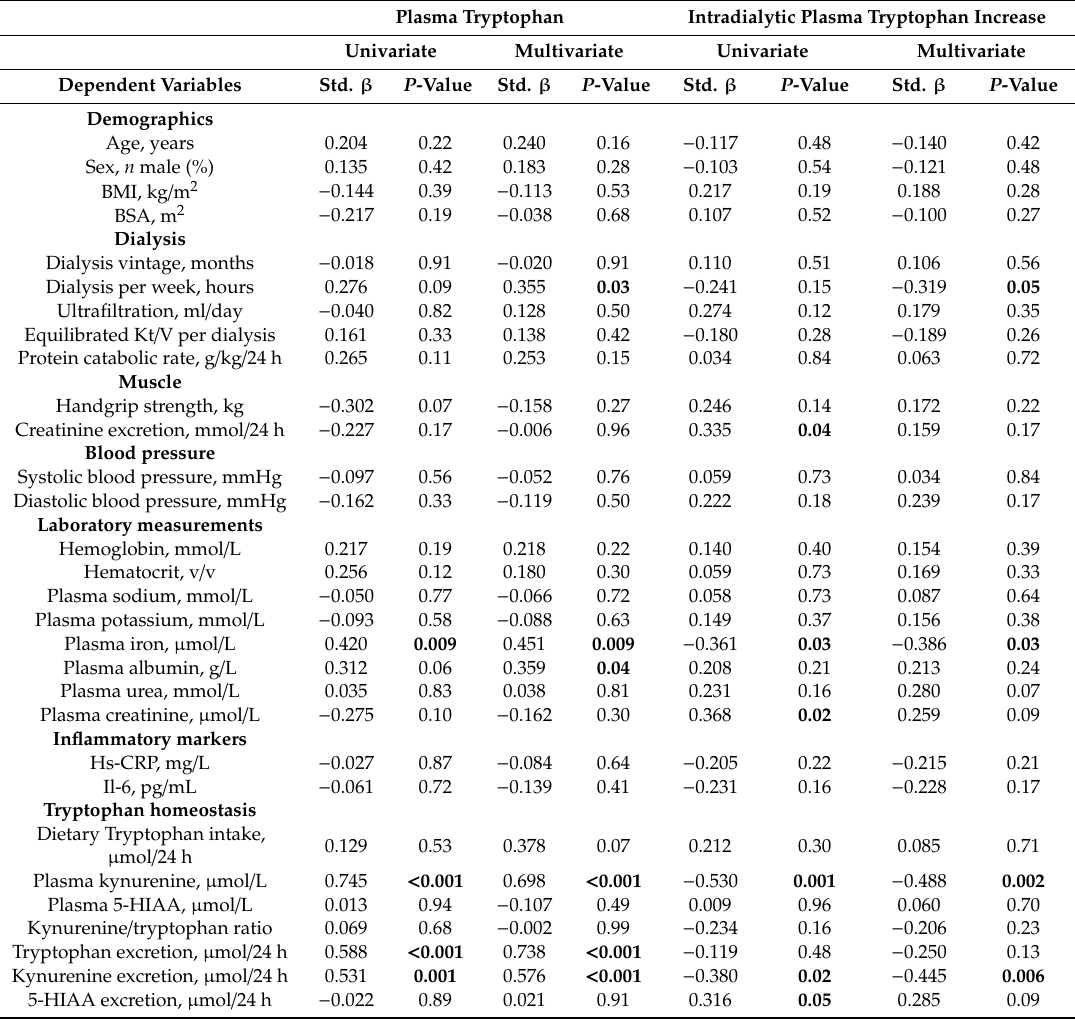
Table 4. Linear regression analyses of plasma tryptophan before dialysis and the absolute plasma tryptophan increase during